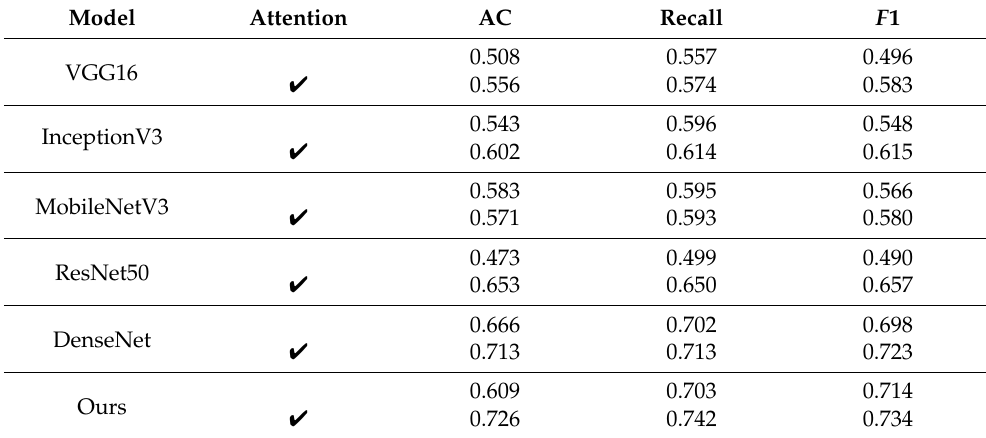
Table 5. Comparison of the method introduced in this paper with other classification models with respect to the M 2 module. The first row of experimental results presents the results without the attention module. The second row presents the experimental results using the attention module.